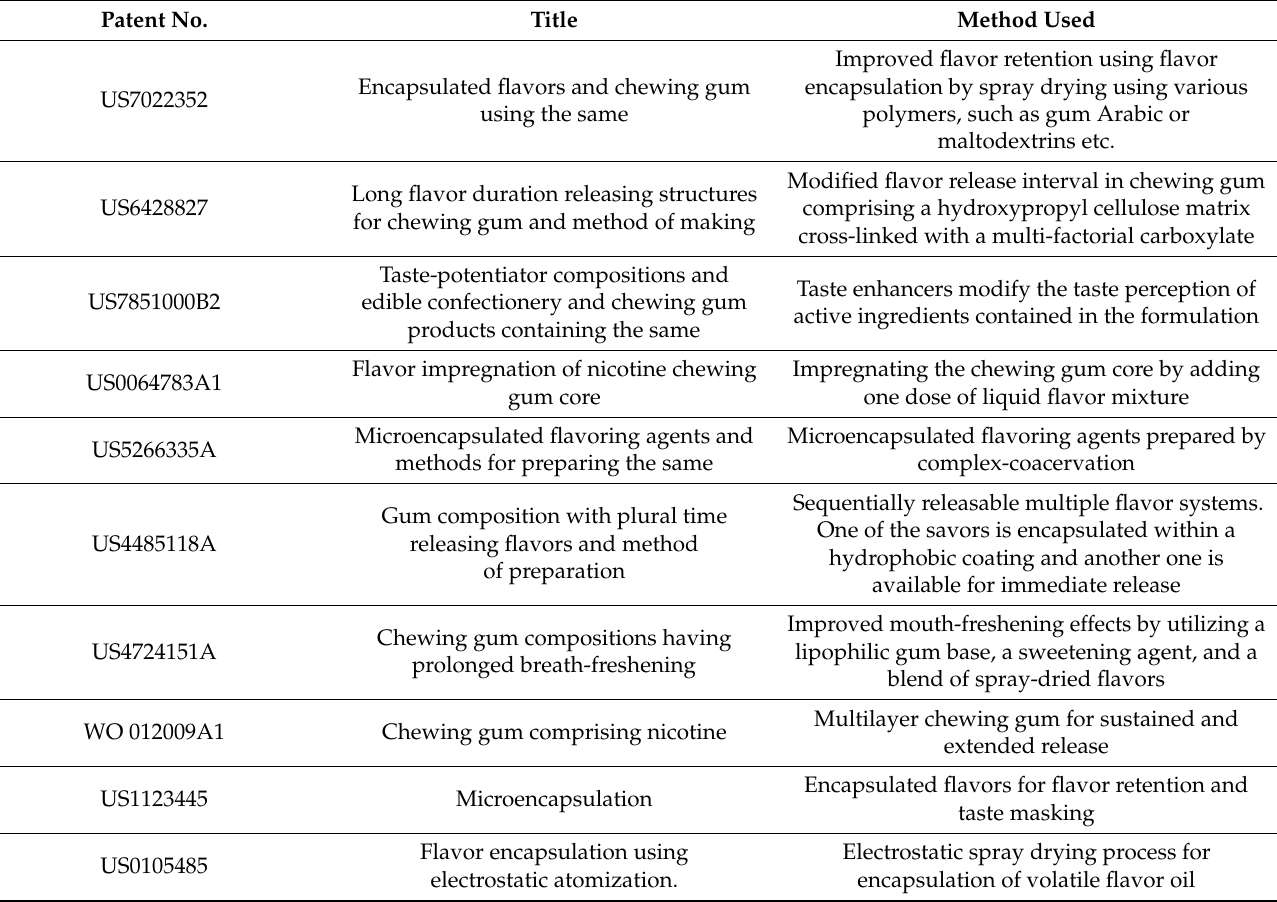
Table 3. Patents on taste masking of medicated chewing gum using microencapsulation. Patent